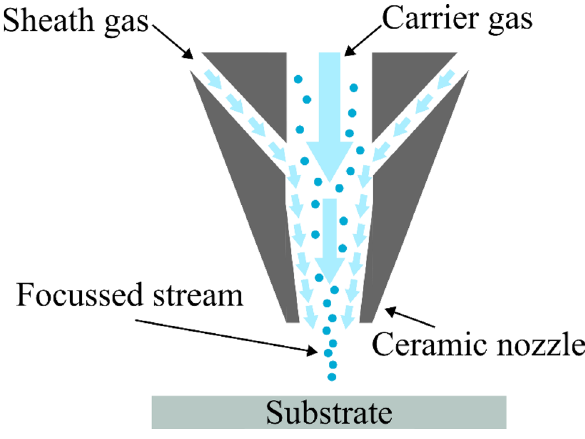
Figure 2. Diagrammatical representation of the aerosol jet deposition head.